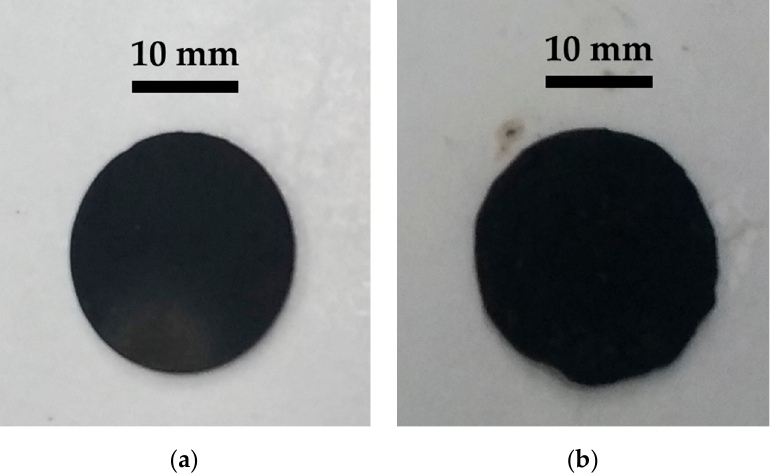
Figure 18. ( a ) Sample debound at 0.2 °C/min for the longer set of holding times; ( b ) sample de- bound at 1.0 °C/min for the longer set of holding times.